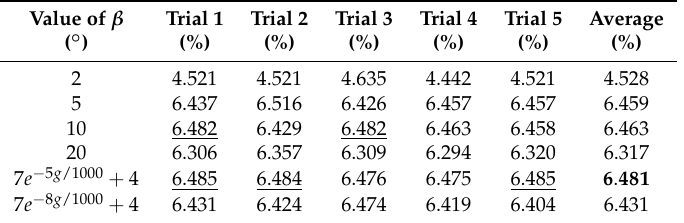
Table 2. Percent improvement in power with differing β values at D = 60 m with northerly wind (0 ◦ direction sector, 10 degree sector, averaged over 0.1 ◦ increment) after 1000 iterations and five trials. Best five objective values are underlined and the best average is boldfaced.